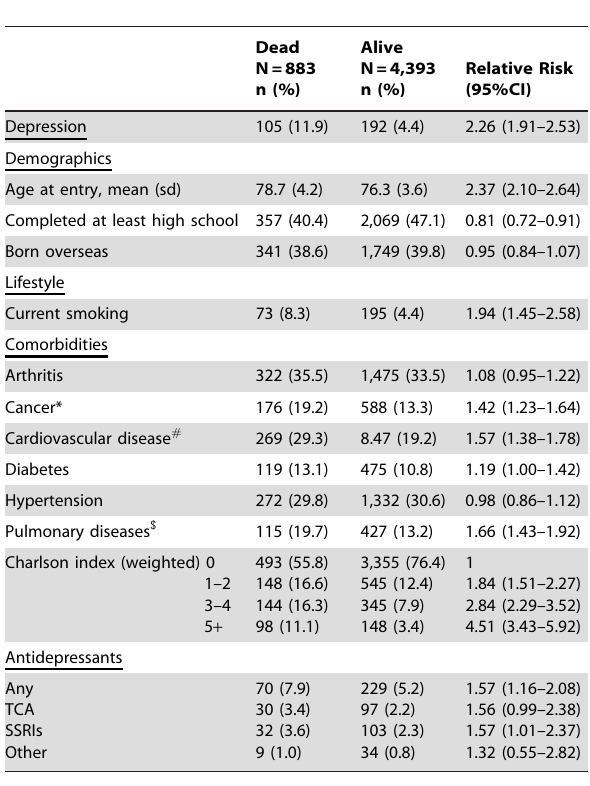
Table 2. Demographic, lifestyle and clinical factors associated with death during follow